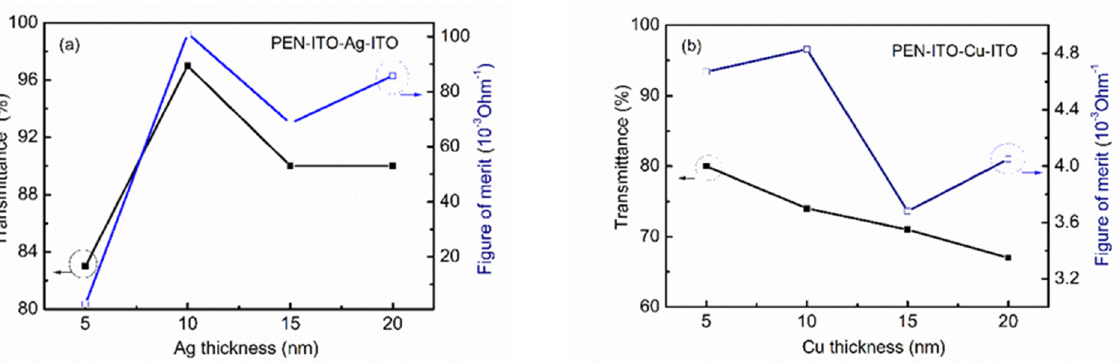
Figure 7. Transmittance at the wavelength of 550 nm and figure of merit of ( a ) IAgI and ( b ) ICuI samples as a function of the metal interlayer thickness on the PEN substrate. Table 3. Largest Φ TC , minimum sheet resistance ( R s ) and maximum optical transmittance of sandwich transparent conduc- tive films deposited with various methods reported in this study and other literature.